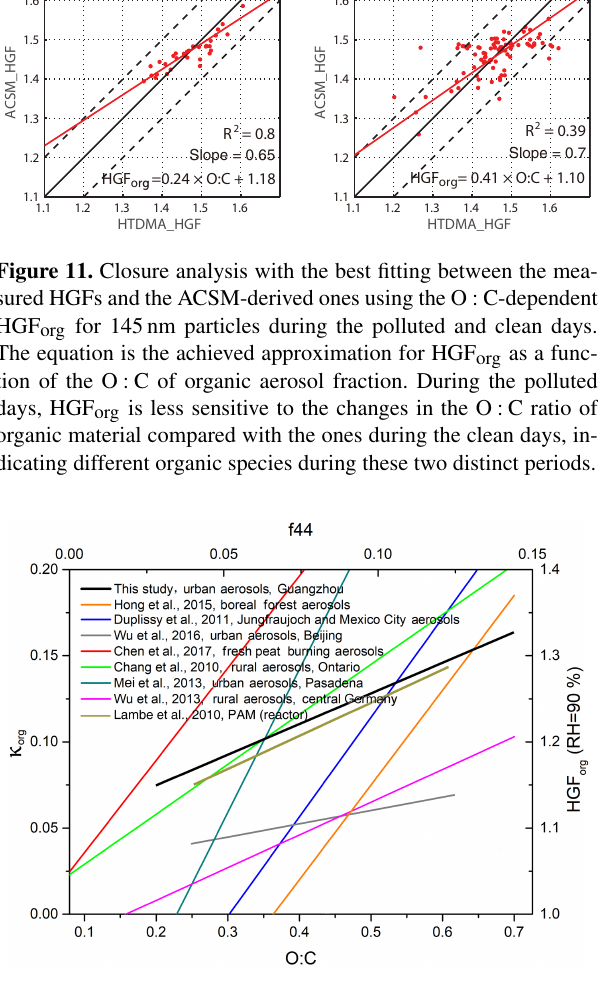
Figure 12. Comparison with earlier studies on the hygroscopicity of organic material with the atomic O : C ratio (or f44 from chemi- cal composition data) obtained from different environmental back- ground areas. In this figure, HGF org in this study was converted to κ org for